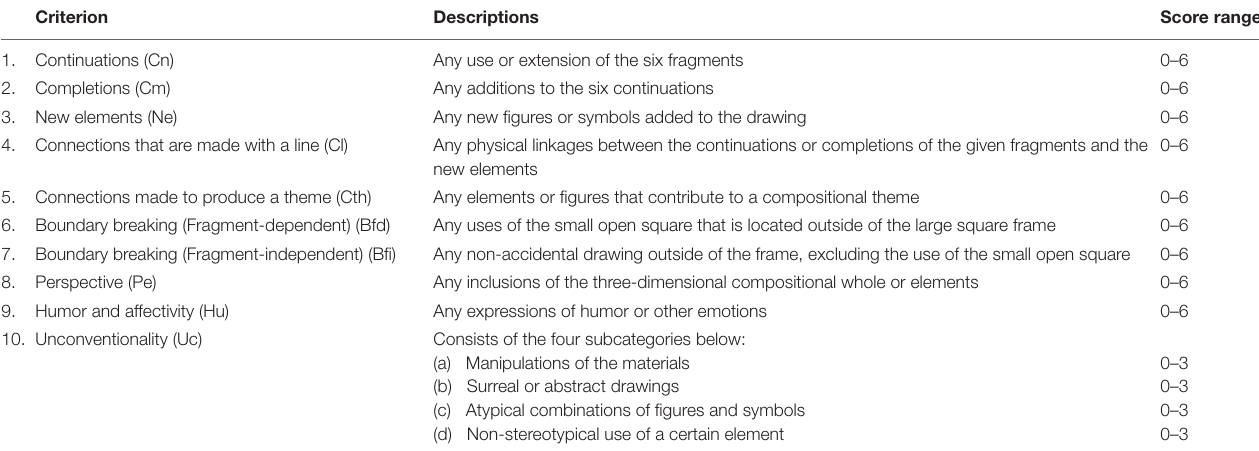
TABLE 2 | Scoring criteria of the